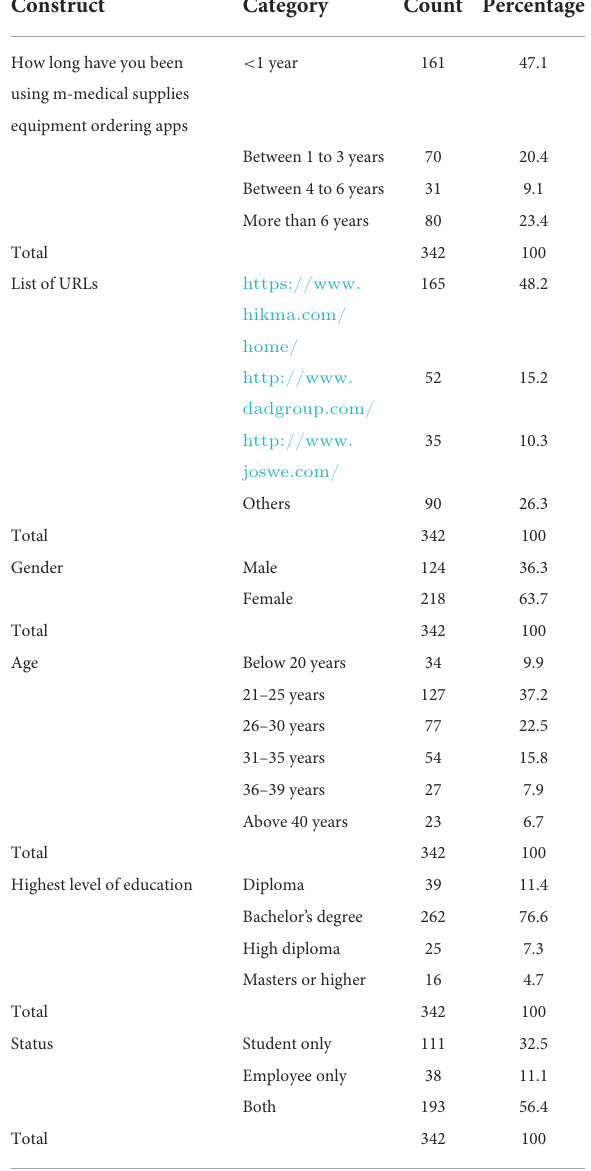
TABLE 3 Respondents’ demographic